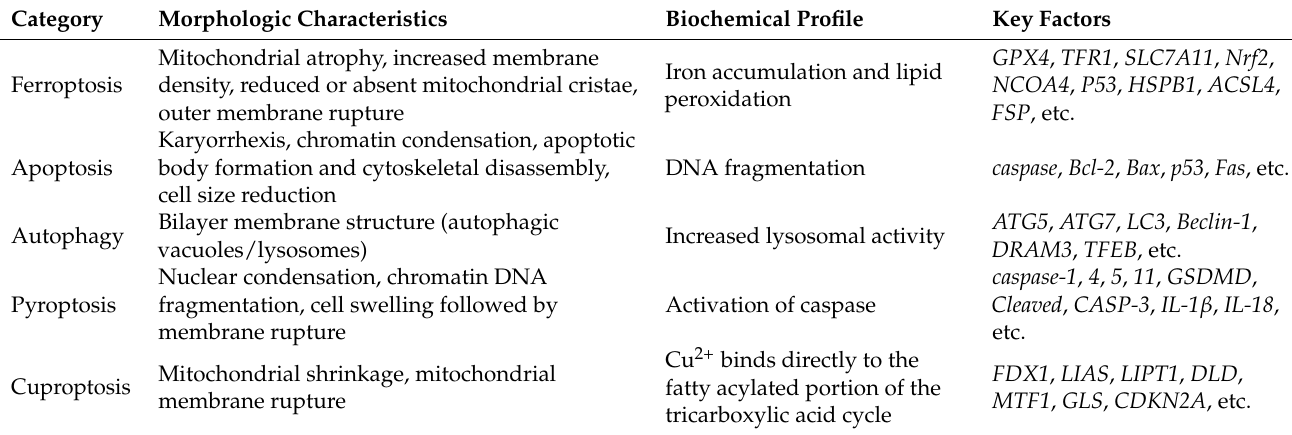
Table 1. Characteristics of different programmed cell